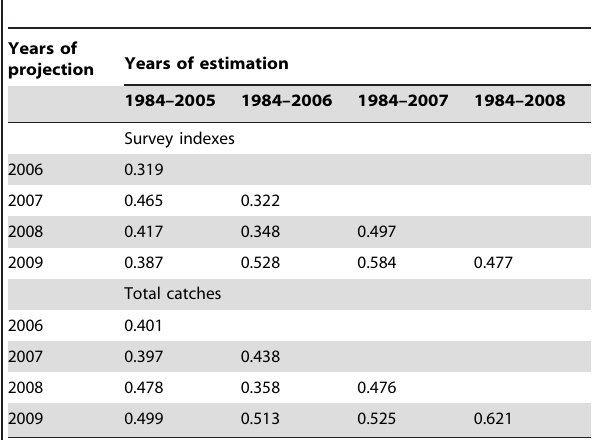
Table 7. P { values of survey indexes (summed over ages 2 to 11) and total catches (summed over ages 5 to 13) with respect to their respective predicted (propagated) distribution, calibrated by maximum likelihood estimation over the previous